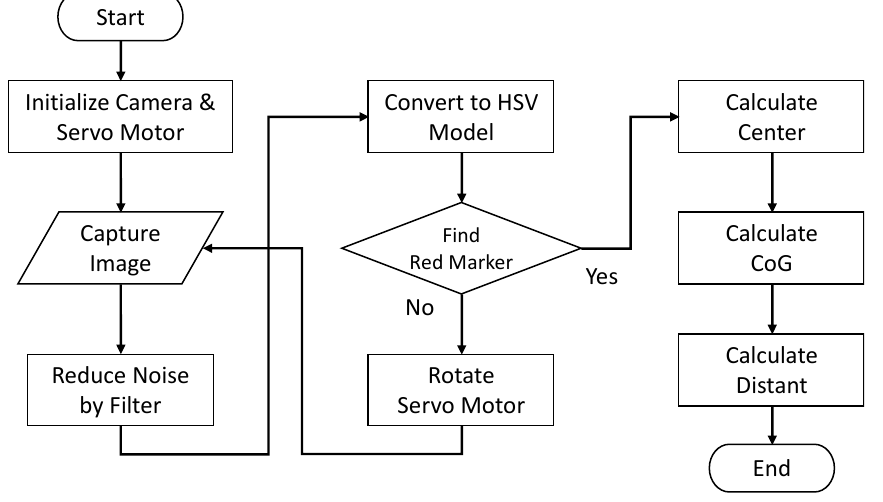
Figure 3. Flowchart of the image processing.